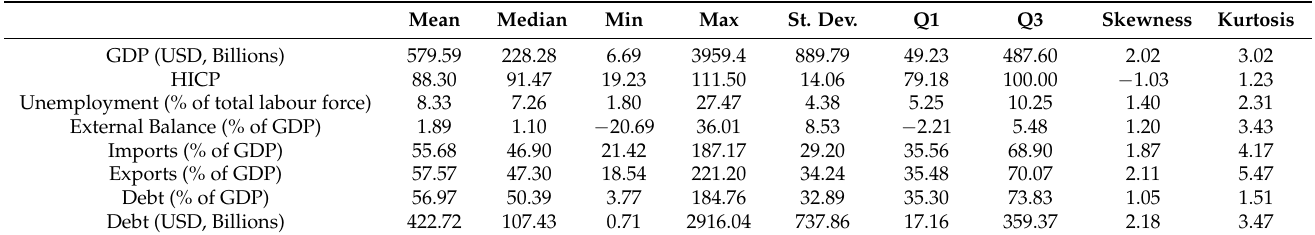
Table 2. The descriptive statistical analysis of the eight macroeconomic variables examined.